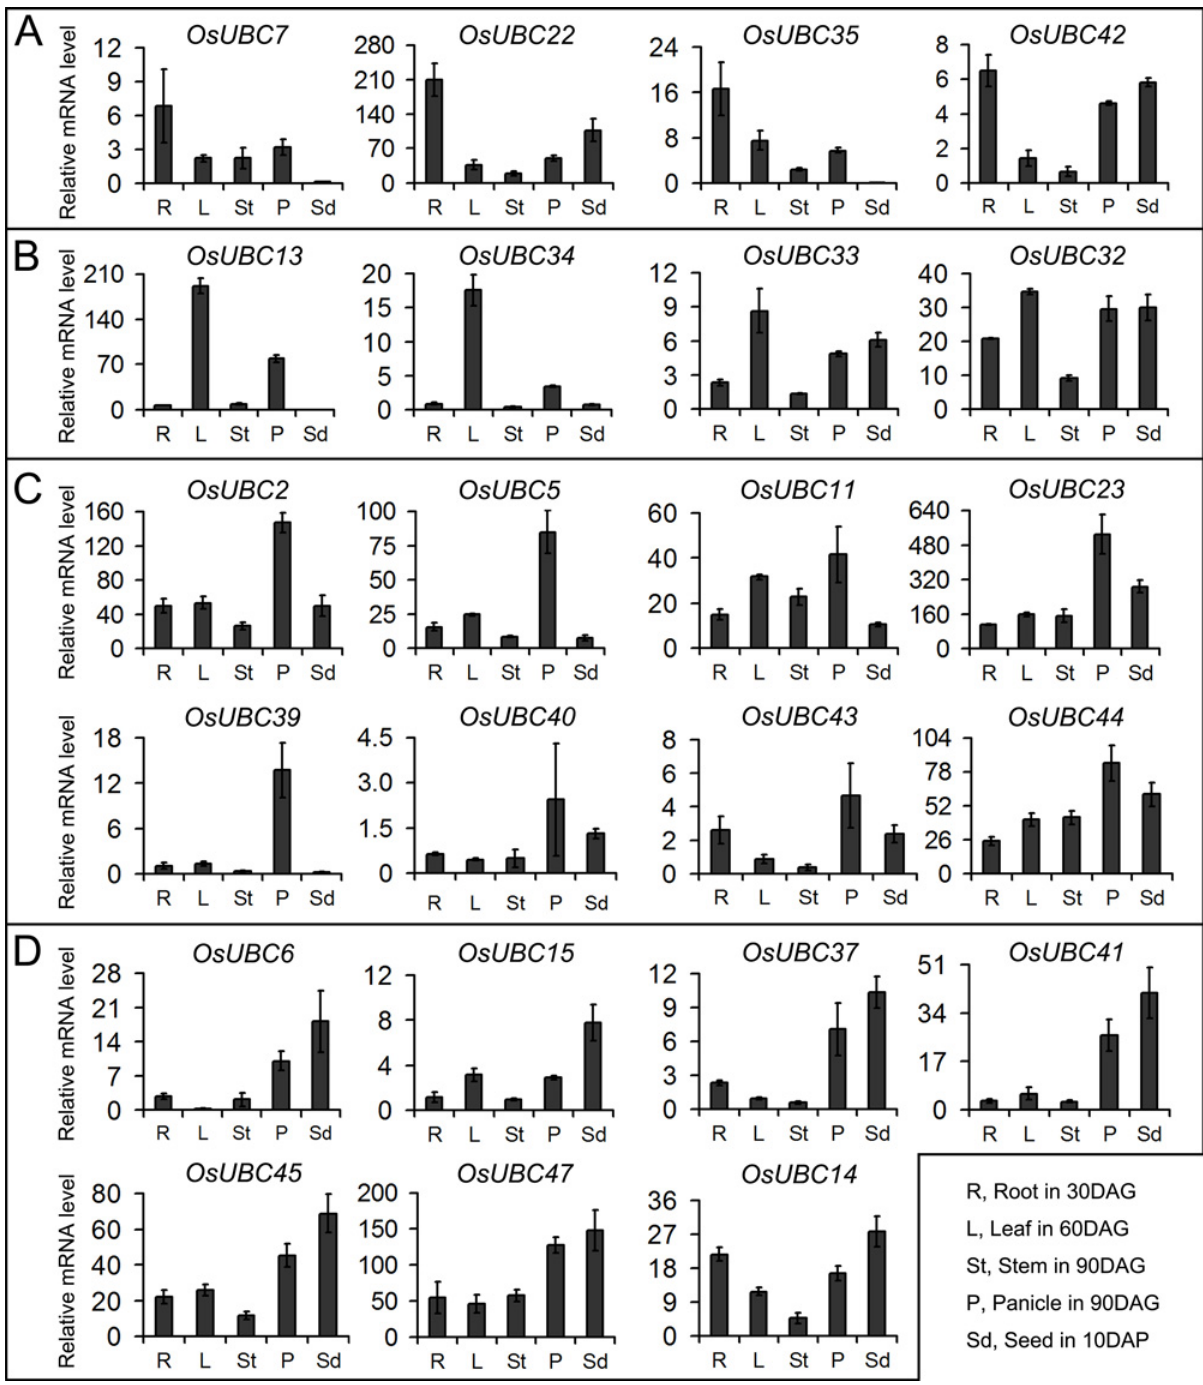
Fig 5. Real-time PCR analysis of tissue-specific expression of the OsUBC genes. Relative mRNA levels of individual genes normalized to UBQ5 are shown. The genes with preferential expression levels in roots (A), leaves (B), panicles (C) and seeds (D) were showed. Error bars indicate standard deviations of independent biological replicates (n = 2 or